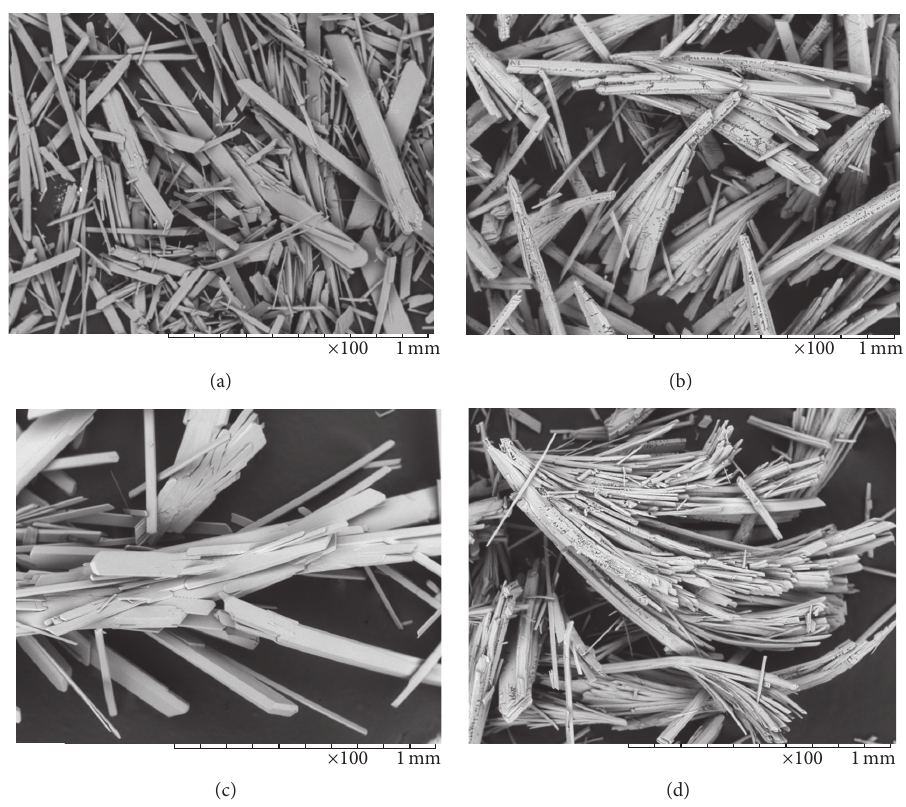
Figure 2: SEM images ( × 100) of gypsum crystals isolated from a blank NACE solution (a) and from the brines in the presence of 0.5 mg ⋅ dm −3